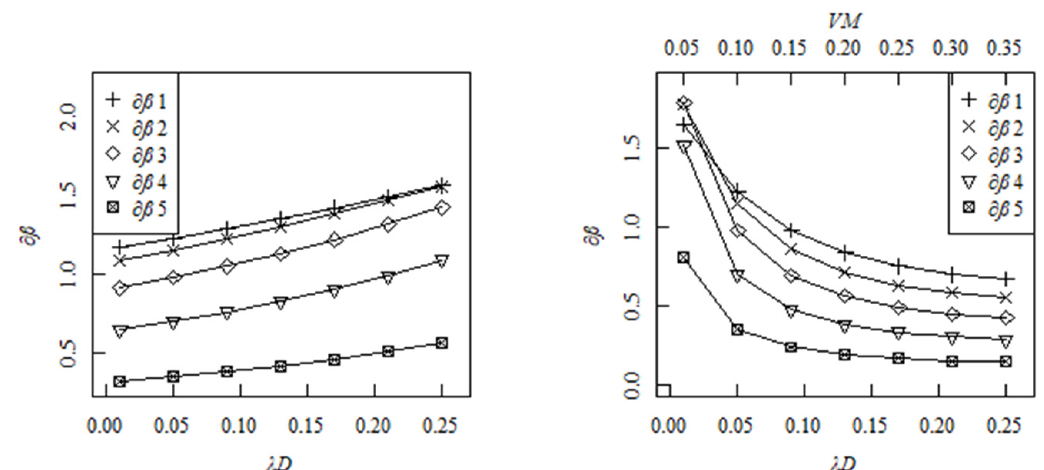
Figure 8. Different sensitivities of the structural robustness evaluation index ( R ∂ ) and structural reliability index ( β∂ ) of the cantilever beam subjected to damage effect ( D λ ) and variation factor ( VM ) (Top left: R ∂ and β∂ vs. Element No. , top right: R ∂ vs. D λ . Bottom left: β∂ vs. D λ , bottom right: β∂ vs. D λ and VM ).